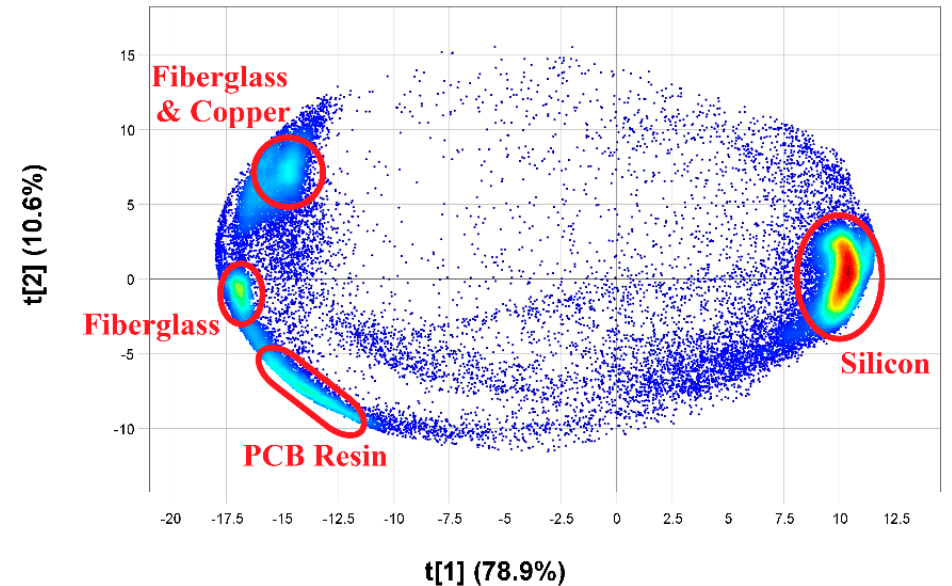
Figure 6. PCA score plots of the first two principal components, t1 and t2.